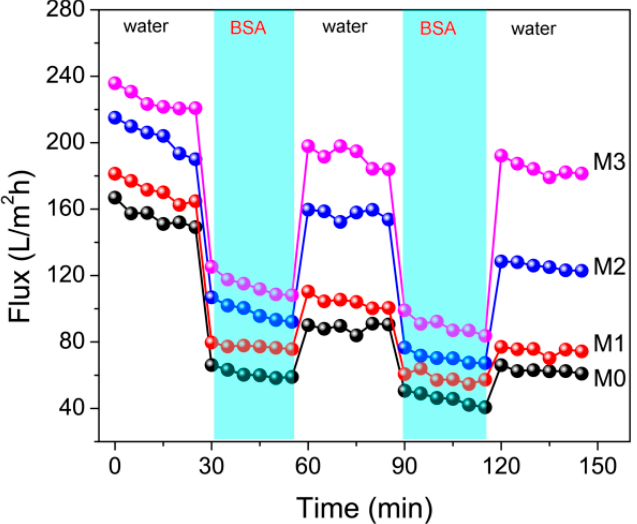
Figure 7. Cycle filtrations of membranes. The each cycle includes three steps: Pure water filtration, BSA solution (1 g/L) filtration and pure water filtration process after water flushing.